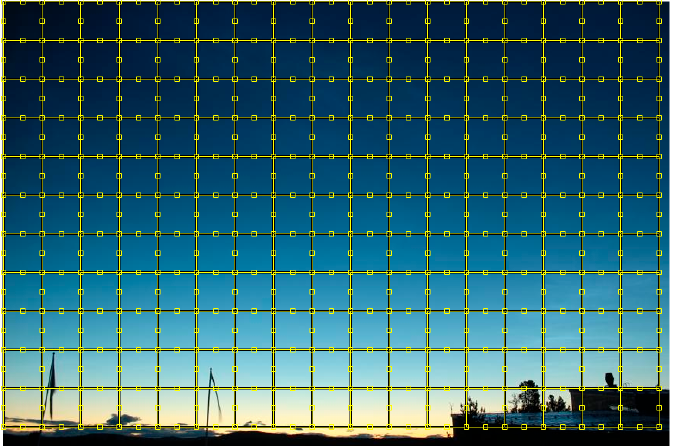
Figure 4. Resized image divided into blocks of size N-by-N pixels.